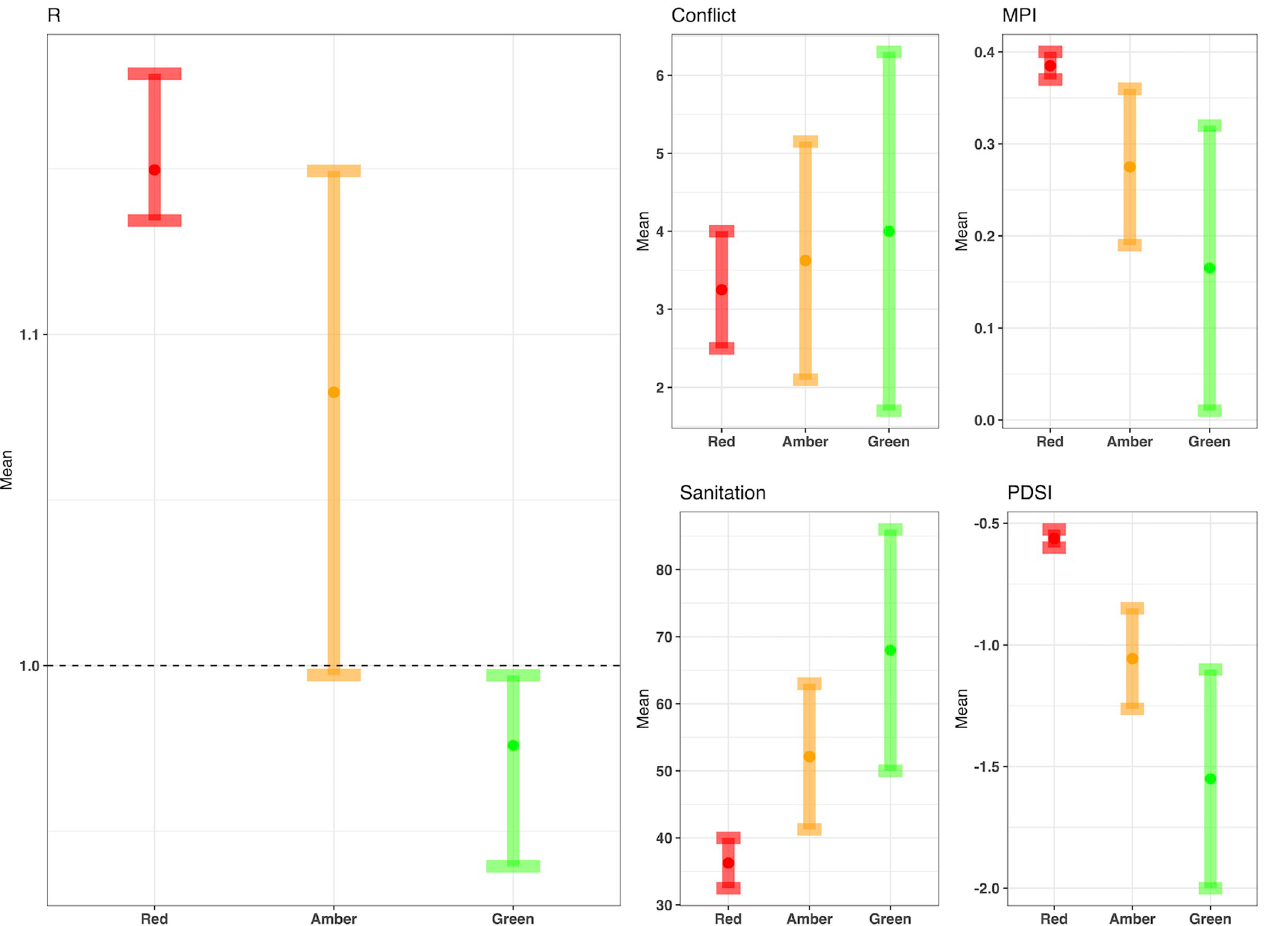
Fig 7. Traffic-light system of cholera risk. The three traffic-light scenarios (Red = R over 1, Amber = R around 1 and Green = R less than 1) for each of the four covariates in the best fit model and the corresponding predicated R value using the best fit model.